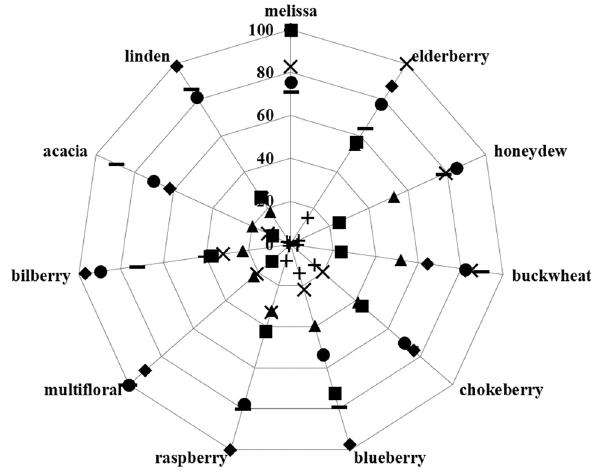
Figure 2: Correlation between relative ( from 0 to 100% ) concentration of ethanol ( ♦ ) , sugar (-) , PF ( ▲ ) , TAP DPPH ( ■ ) , TAP OH ( ● ) , TAP ED - 1V (×) , and TAP ED - 0.4V (+) of the produced